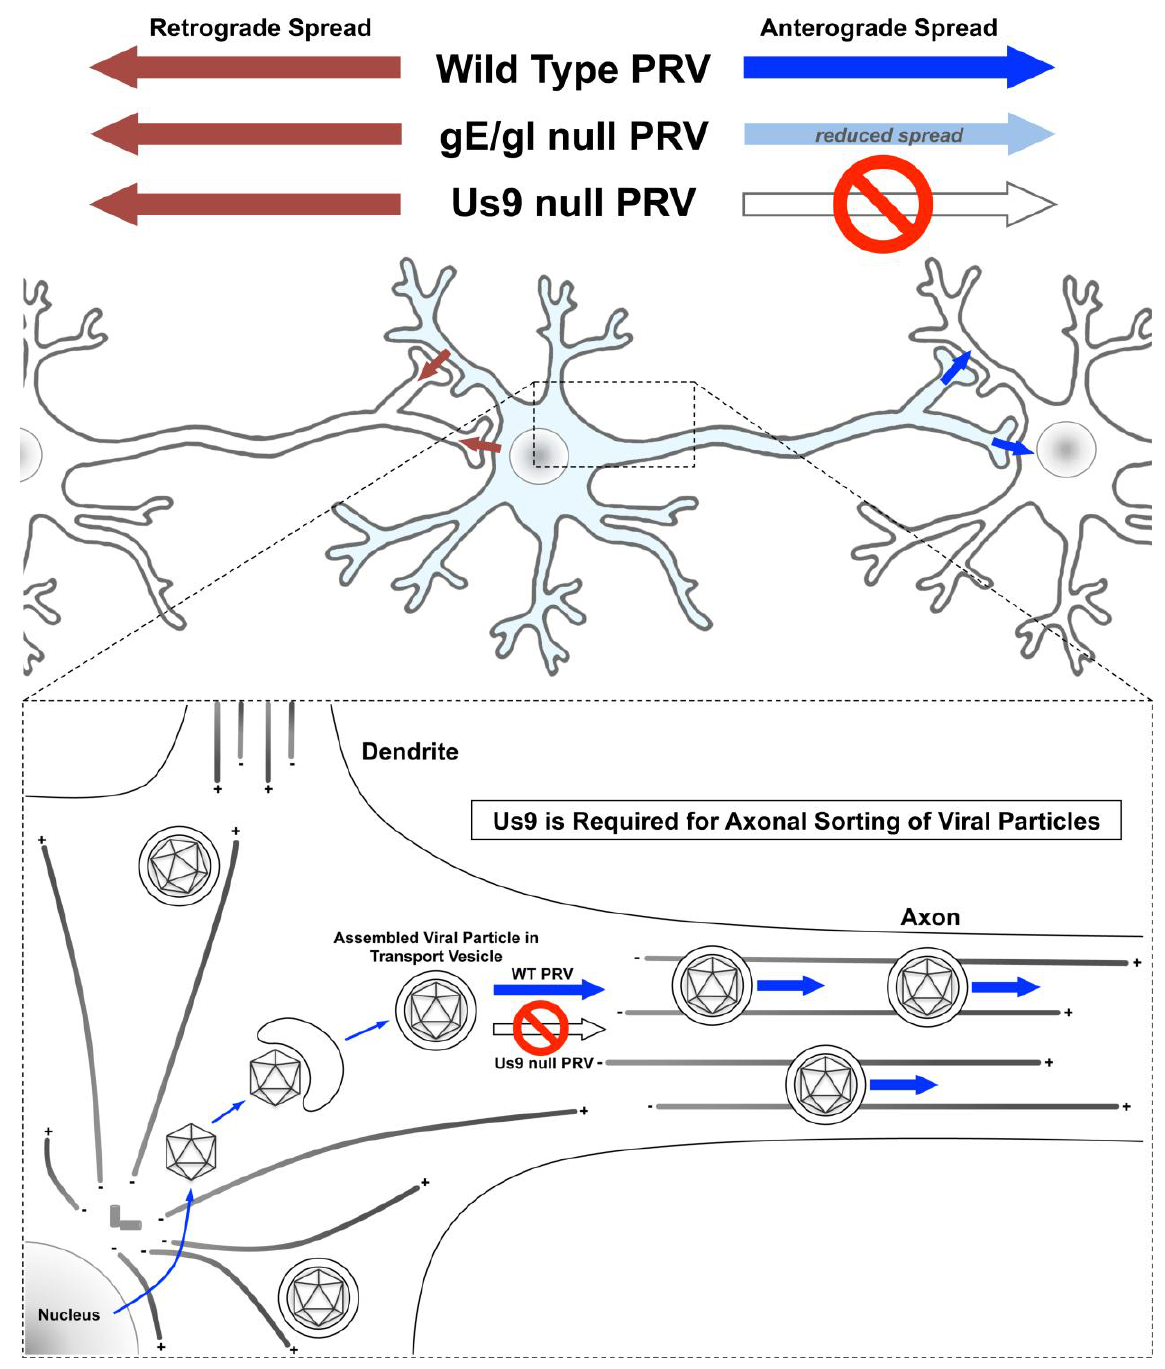
Figure 3. PRV Us9 and gE/gI mediate anterograde spread of infection in neurons. PRV Us9 is essential for anterograde trans-neuronal spread in vivo and in vitro . In the absence of Us9, viral particles are assembled in the cell body, but are not sorted into axons. This neuron-specific phenotype suggests that Us9 functions by recruiting a molecular motor protein, either directly or indirectly, that facilitates axonal sorting of viral particles into axons. In contrast, gE/gI null mutants are defective for anterograde trans-neuronal spread in vivo , but are able to spread with reduced capacity in vitro . gE/gI null mutants display a small plaque phenotype in non-neuronal cell